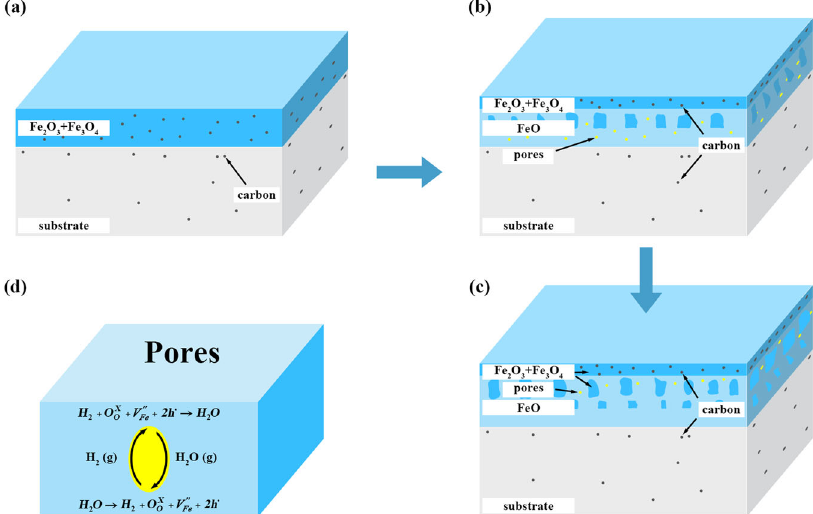
Fig. 8 Schematic diagram of the microstructure evolution of 37Mn5 steels after oxidation in kerosene atmosphere at 700 °C. a Incomplete combustion of carbon exist in oxide scale after combustion in kerosene. b Reduction reactions in Fe 2 O 3 and Fe 3 O 4 , where FeO dissolve out. c As the oxidation proceed, a loose surface induced by the reduction with Carbon. d Accelerate mode of water vapor on the growth of iron.